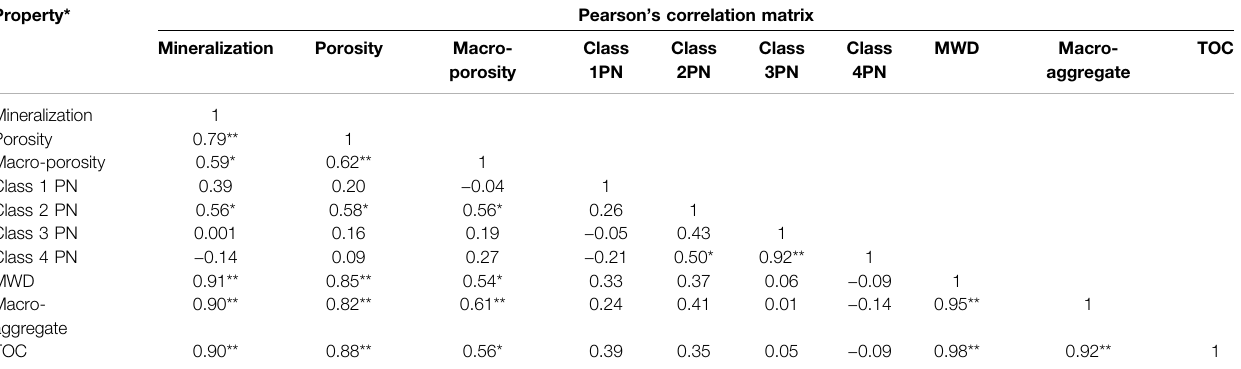
TABLE 5 | Correlation matrix of soil C mineralization and porosity, number of different size pores, mean weight diameter, amount of macro-aggregates, and total organic C. Property* Pearson ’ s correlation matrix